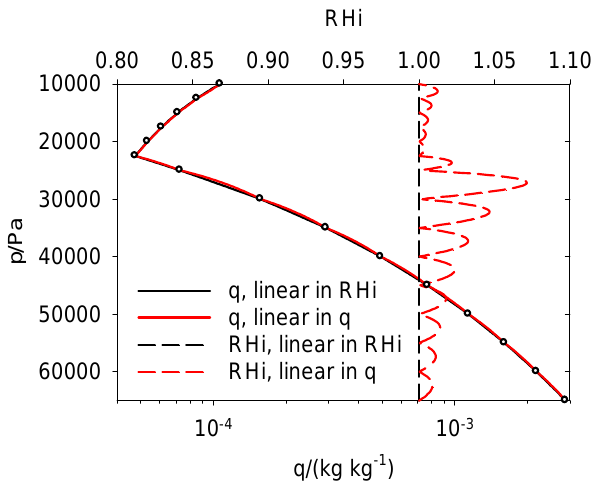
Fig. A1. Illustration of the difference in local relative humidity over ice (RHi) caused by either interpolating in absolute or relative hu- midity. Full curves: Absolute humidity q versus pressure altitude p for the ICAO standard atmosphere with RHi=100%. The dots represent the discrete pressure values as given in the NWP input. Data are constructed for this example (as in the ECMWF data) with 50hPa intervals below 250hPa and 25hPa above that altitude. The full black line represents the interpolation in absolute humidity. The red full line represents the interpolation in relative humidity. Dashed curves: RHi versus pressure altitude p . The dashed black line repre- sents RHi computed by linear interpolation in relative humidity. The dashed red line represents RHi computed by linear interpolation in absolute humidity. The difference in RHi (up to 0.07) between the red and black dashed lines is a consequence of different interpola- tion methods either between discrete q or RHi